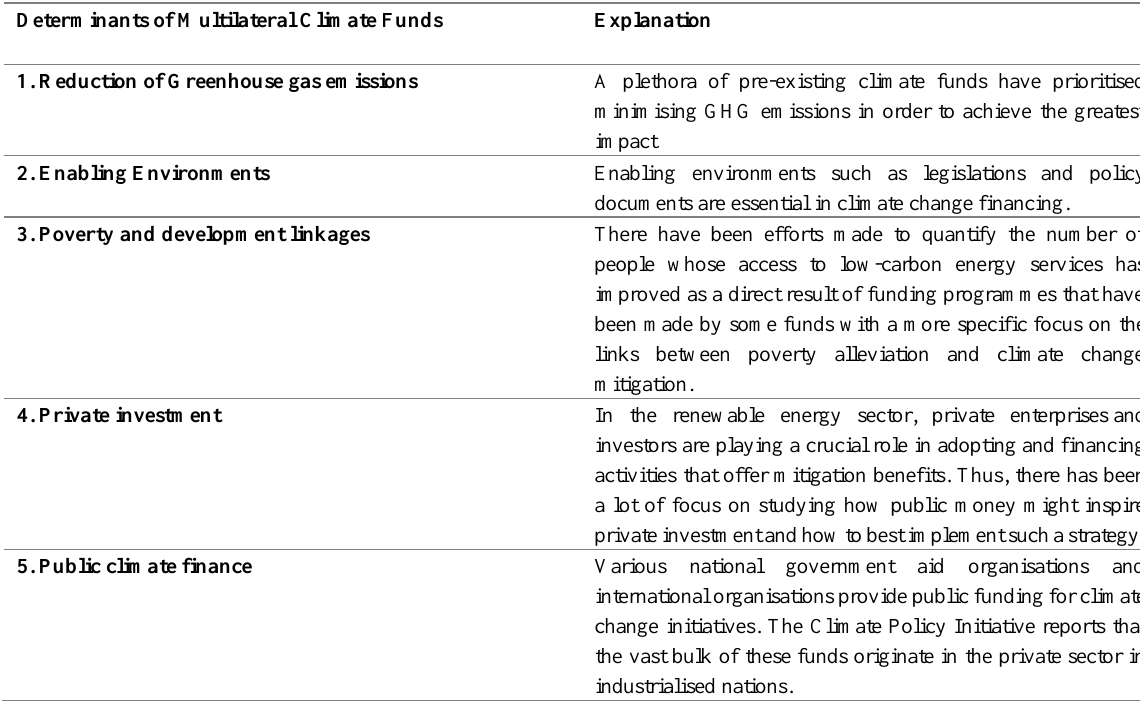
Table 1: Multilateral Climate change